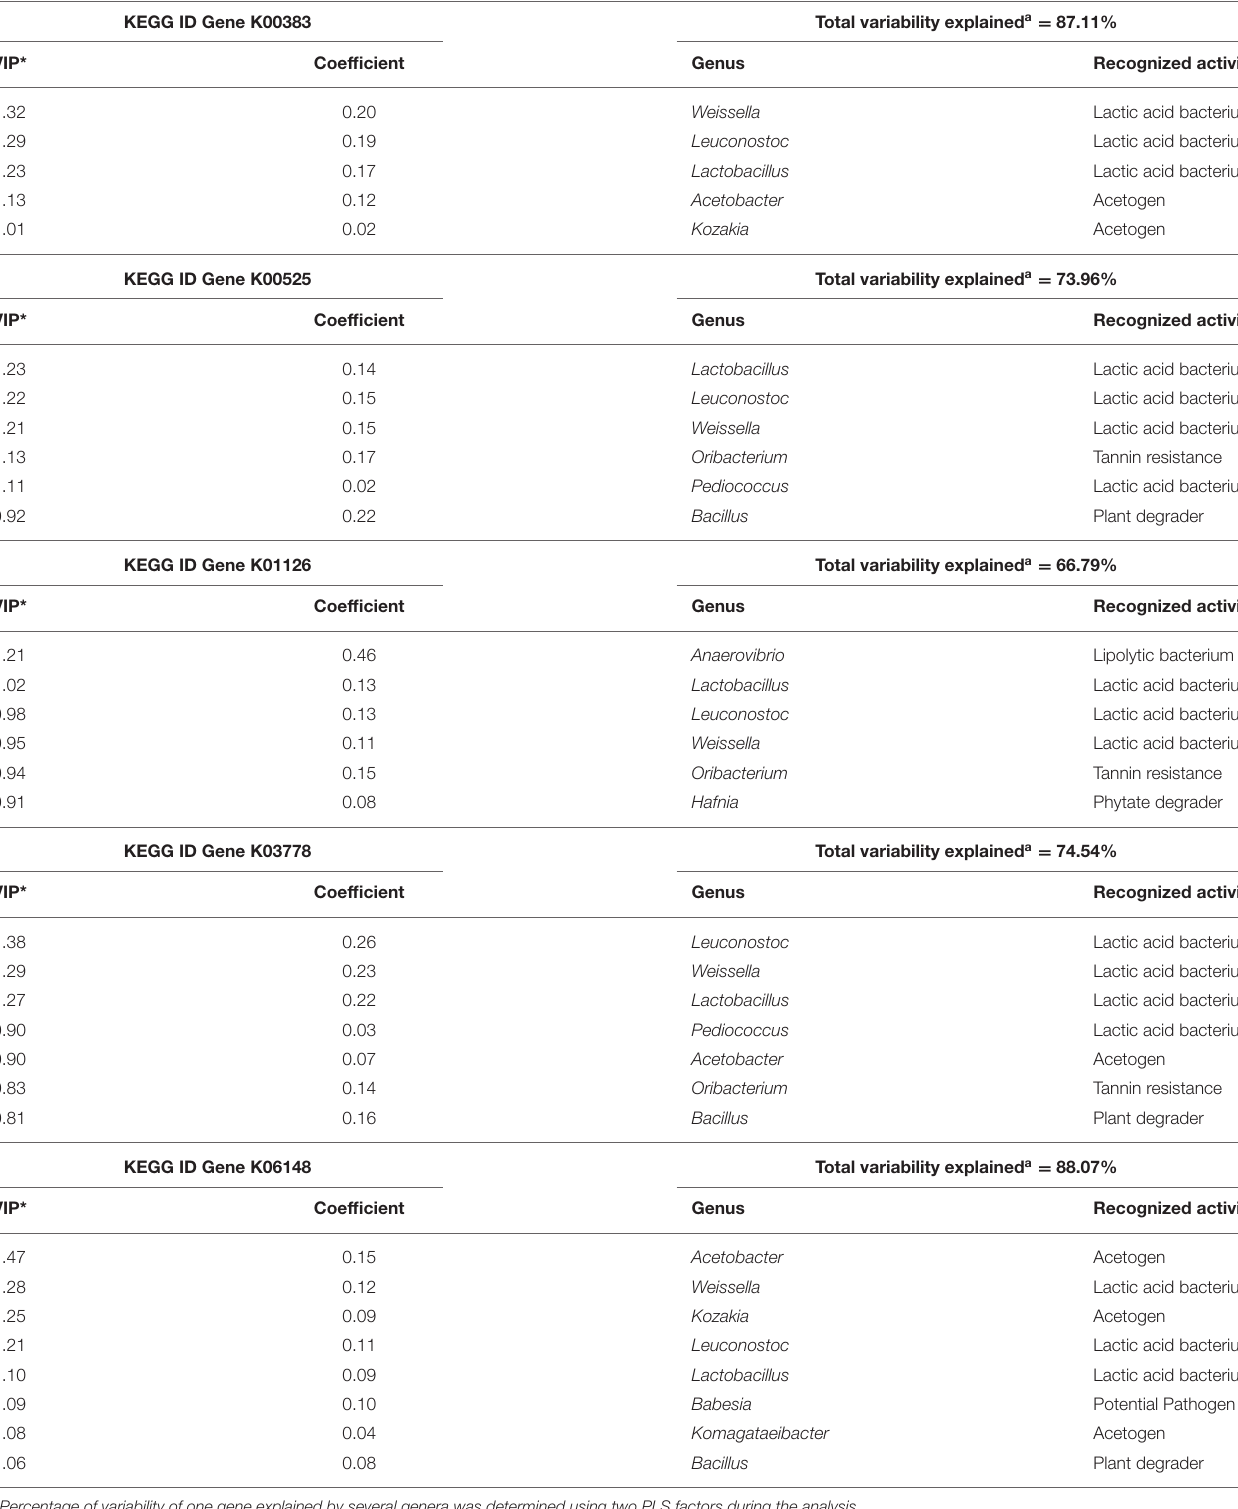
TABLE 2 | Partial Least Square results identifying the most correlated genera with one of the genes identified as of interest explaining metabolomics results (K00383, K00525, K01126, K03778, and K06148). KEGG ID Gene